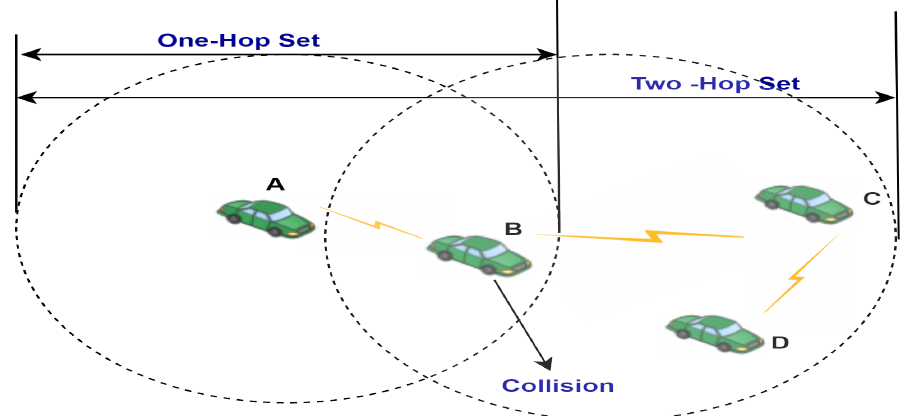
Figure 8. Illustration of hidden terminals